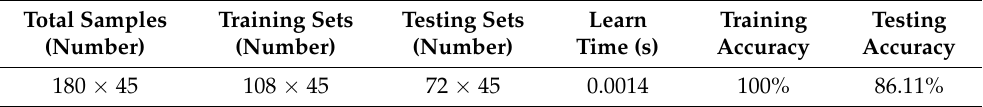
Figure 13. Check valve fault diagnosis accuracy obtained by KELM with different dimensionality reduction methods.